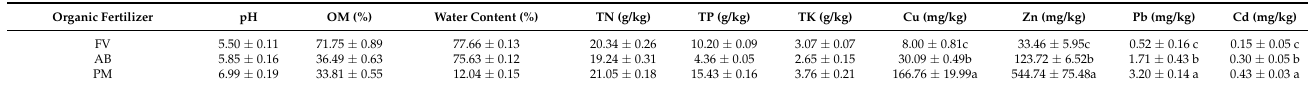
Table 1. Nutrient and heavy metal content of PM and FCR in field experiments. Data are means ± SD, n = 3. Different letters indicate significant differences between treatments at p < 0.05 according to the Duncan